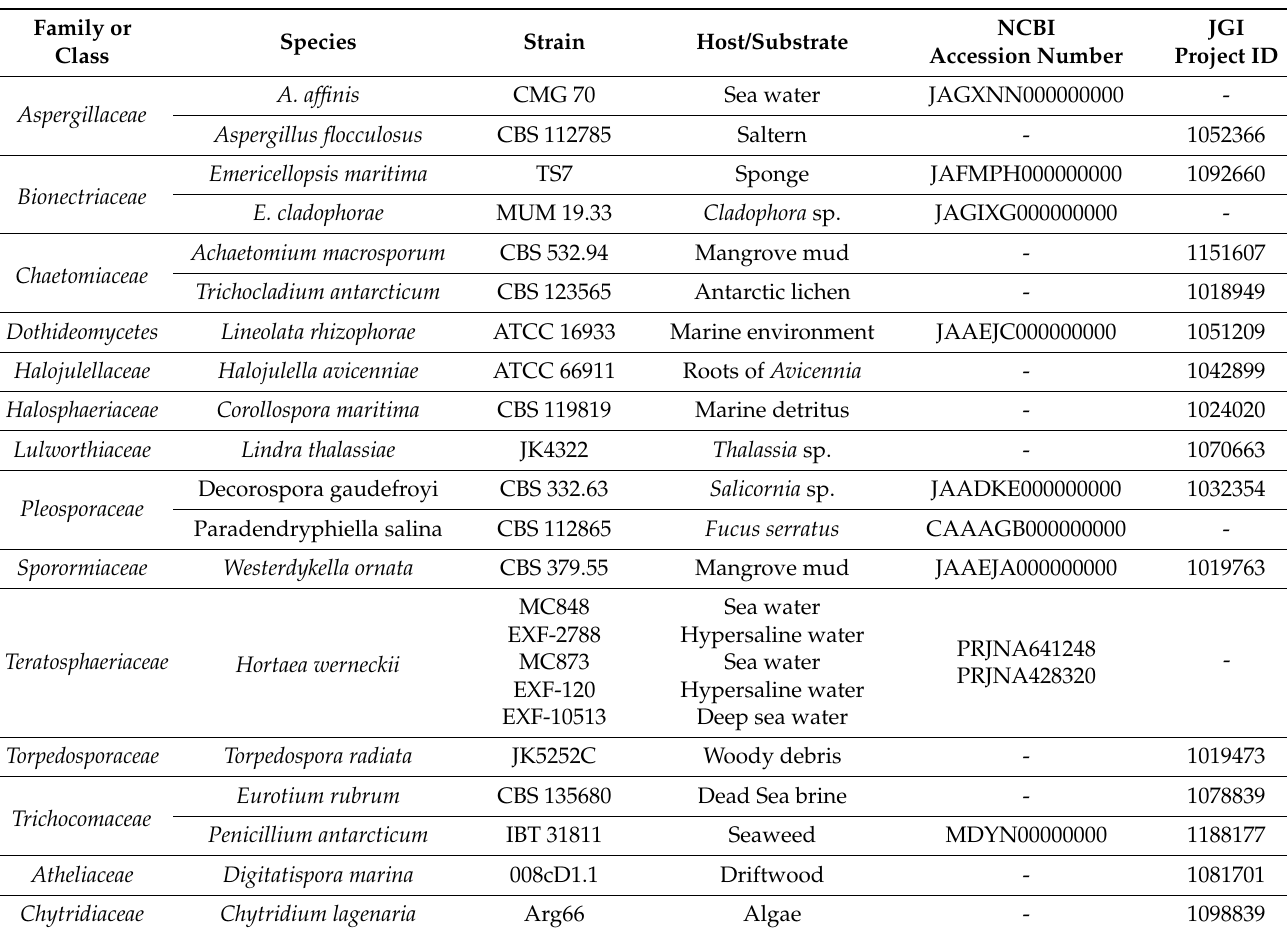
Table 3. Overview of the marine fungal genomes